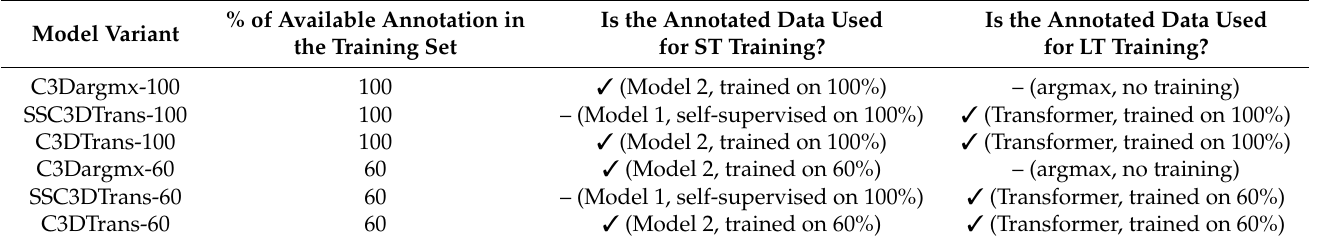
Table 3. Overview of the examined model variants with respect to the percentage of annotated data utilized for